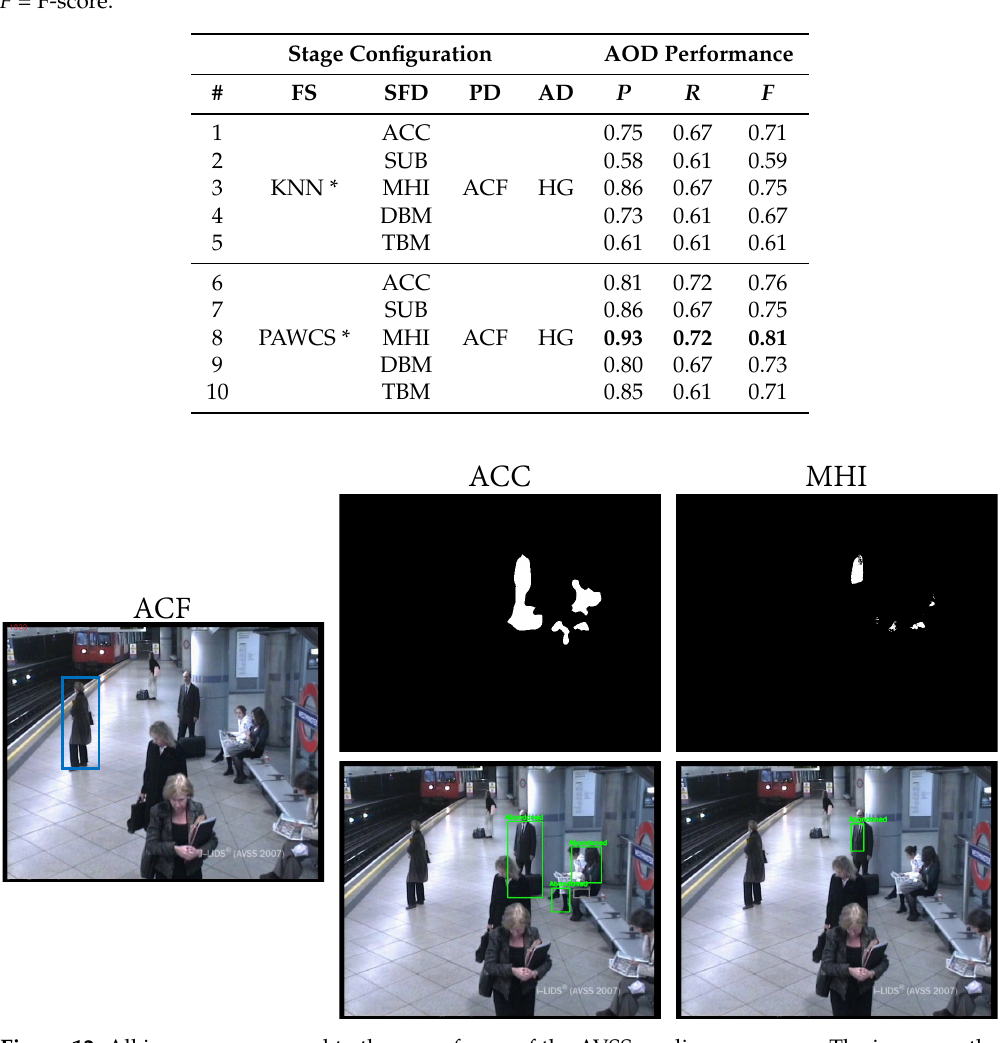
Figure 12. All images correspond to the same frame of the AVSS medium sequence. The image on the left shows in blue the detections provided by the ACF people detector. The top row illustrates the static foreground mask obtained with the ACC and MHI algorithms, respectively, and the bottom row shows their corresponding abandoned